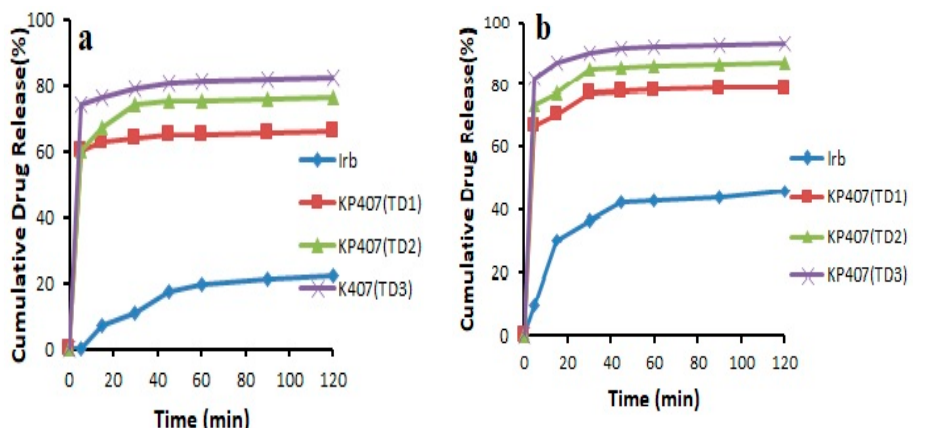
Figure 6. Dissolution profile of pure Irbesartan and ternary solid dispersions prepared with Kolliphor ® P 407 in ( a ) pH 6.8 phosphate buffer ( b ) 0.1 N HCl (n = 3, mean ± SD).